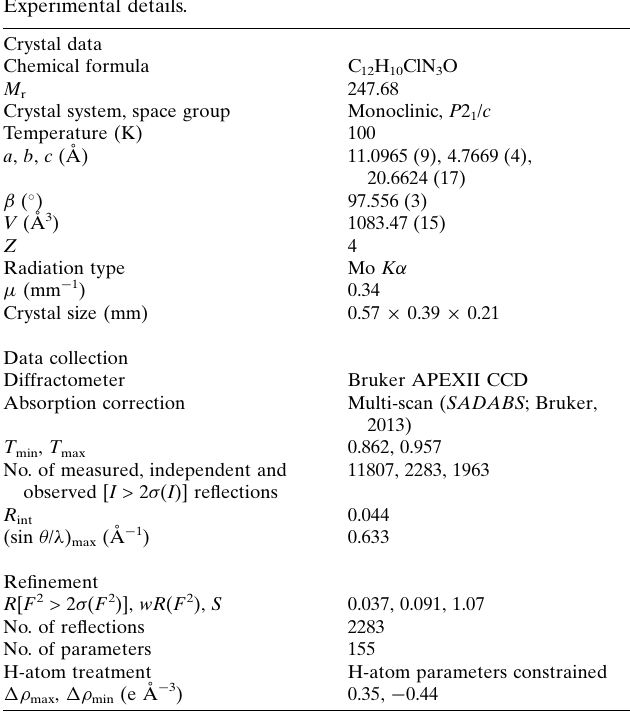
Table 2 Experimental details.